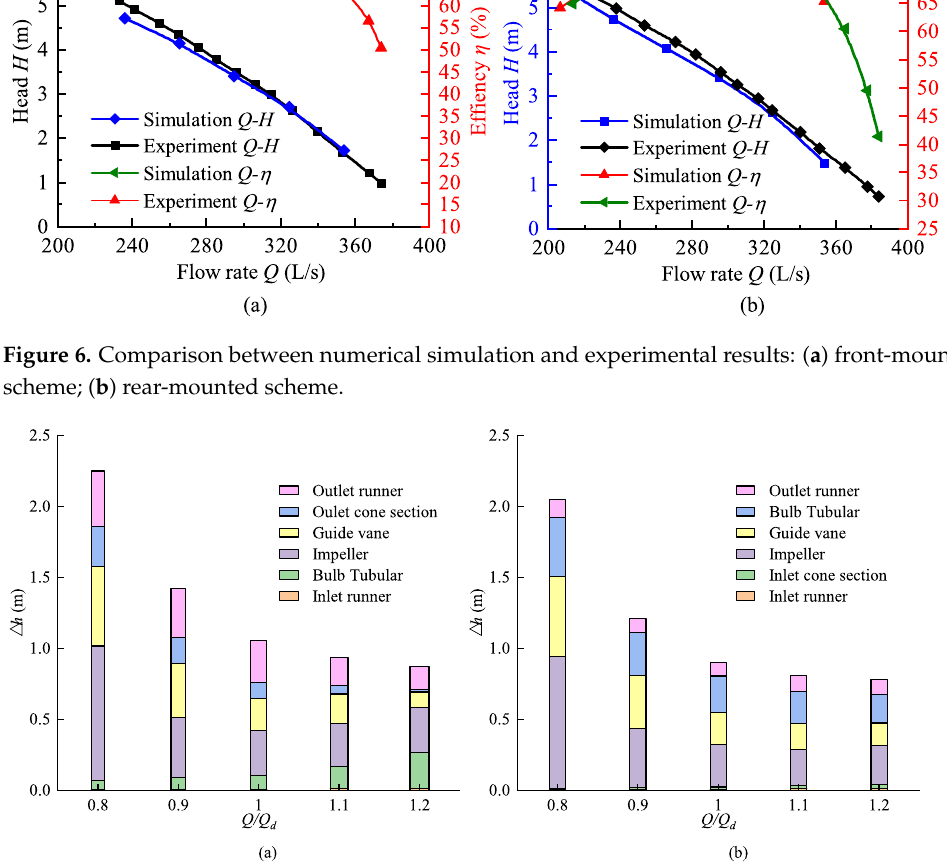
Figure 7. Hydraulic loss analysis: ( a ) front-mounted scheme; ( b ) rear-mounted